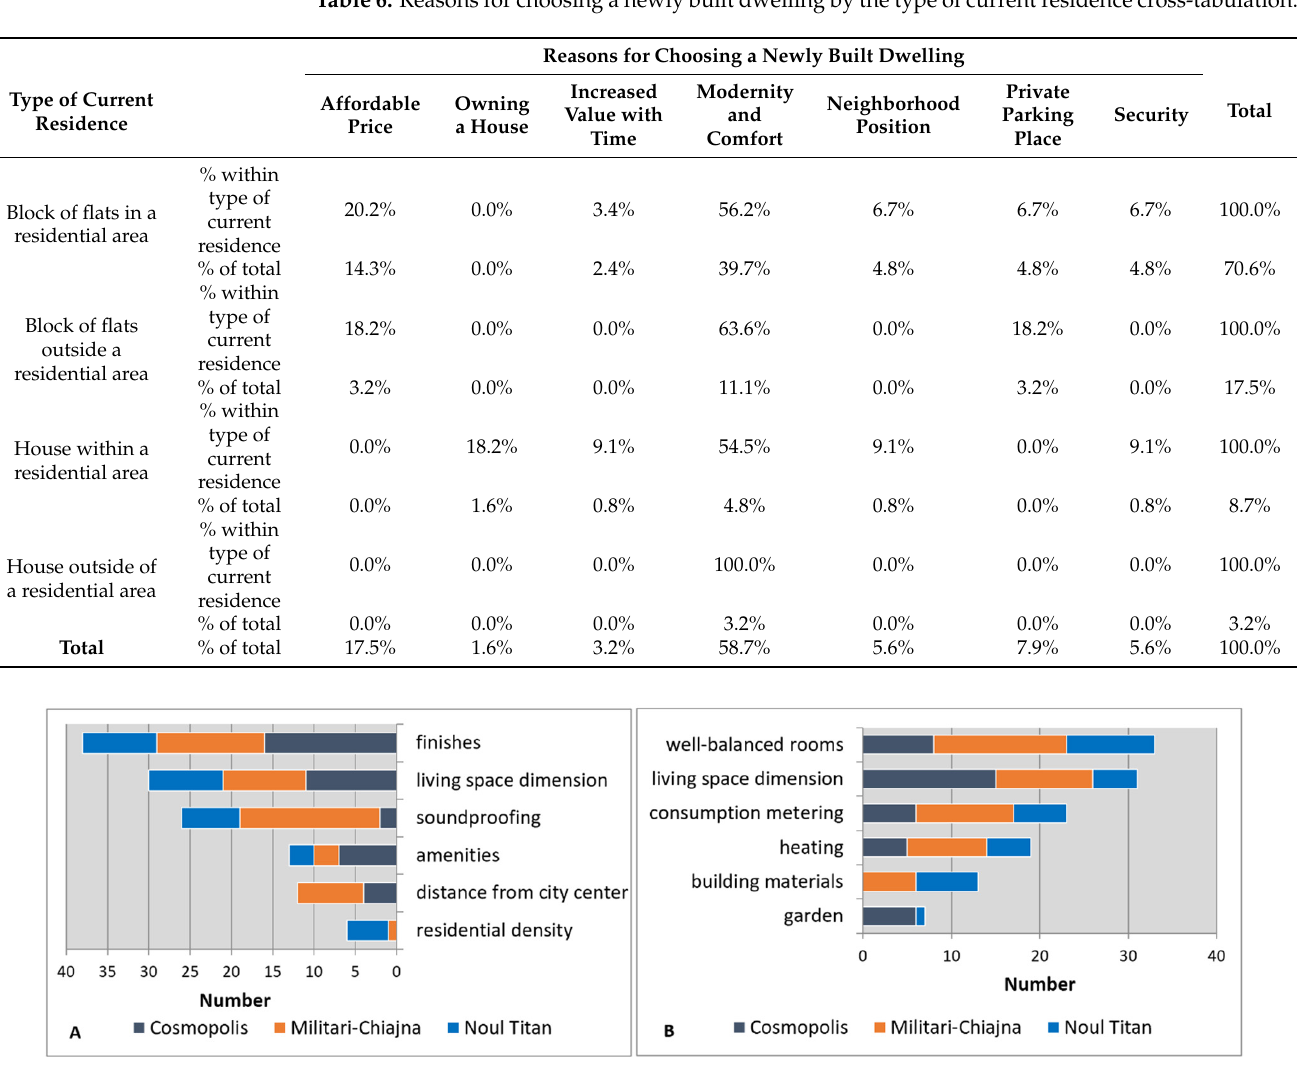
Figure 8. Residents’ dissatisfaction ( A ) and satisfaction ( B ) reasons regarding their newly built